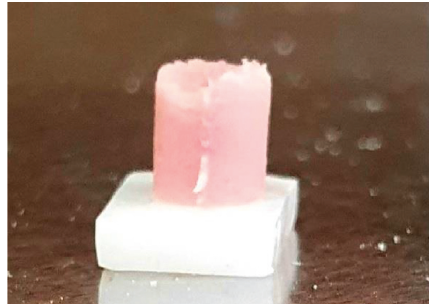
Figure 4: Zirconia-veneering ceramic assembly used for the shear bond strength test. Table 1: Contact angle measurements (in degrees) of experimental groups at different time intervals in the furnace. (min) Control Zr